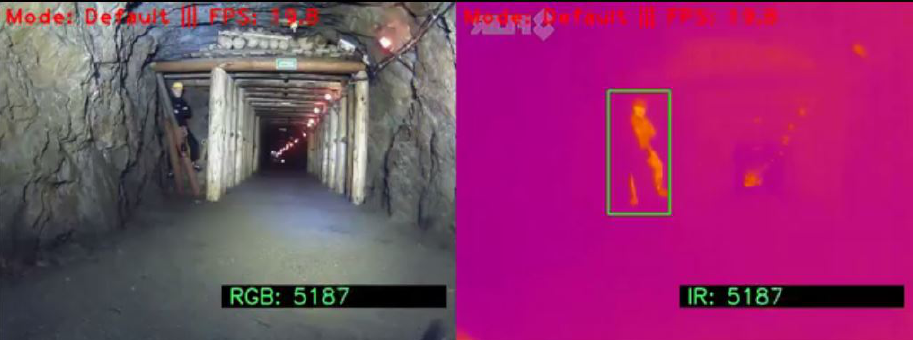
Figure 17. Human obscured—no detection in RGB image, correct detection in the IR image with algorithm